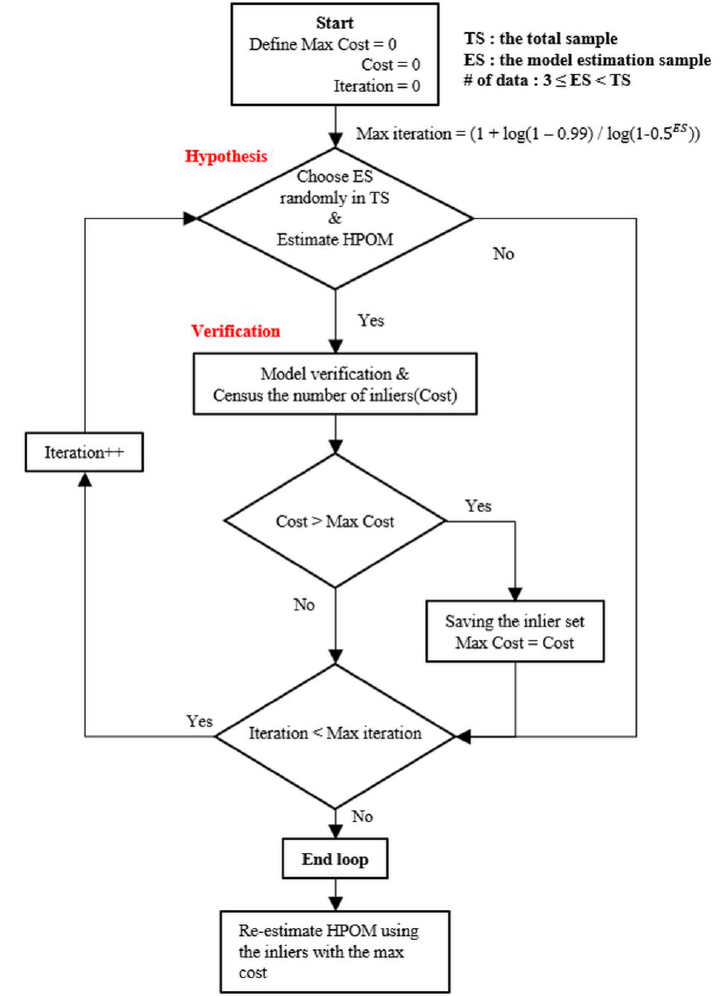
Figure 9. Process of RANSAC to estimate HPOM.